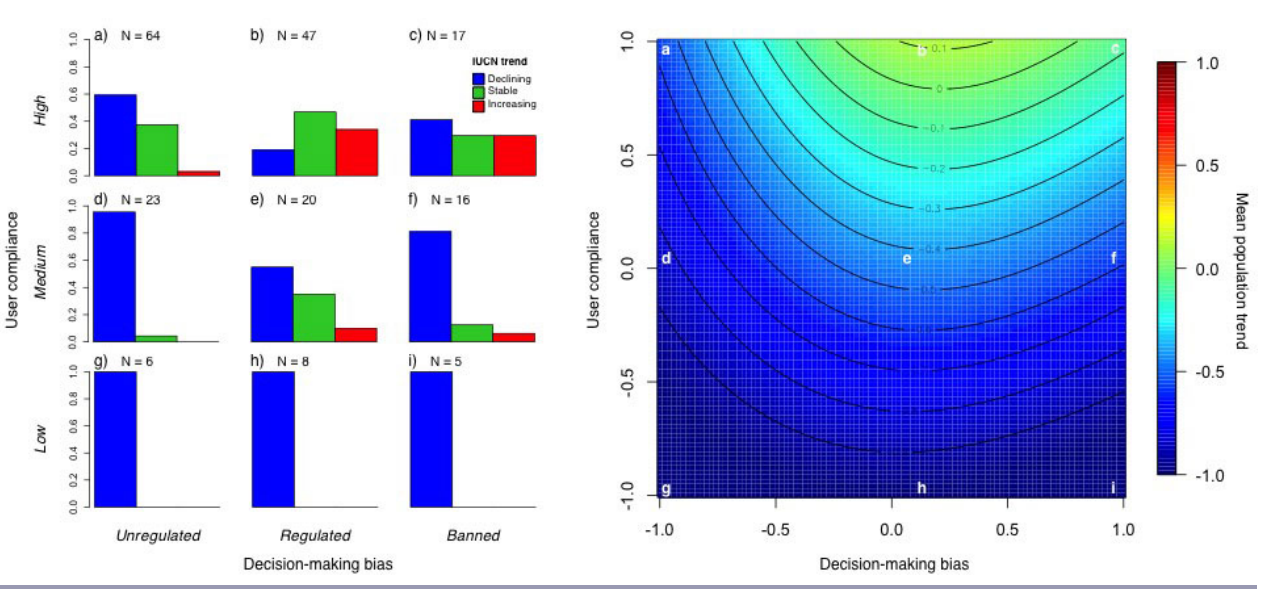
Fig. 4 . Proportion of harvested IUCN Red List species with declining, stable, or increasing population trends for different combinations of decision-making bias and user compliance (panels a-i). N indicates the sample size for each combination. The 2D contour surface represents the interpolated mean population trend across harvested species (-1 = decreasing, 0 = stable, 1 = increasing) for varying levels of decision-making bias and user compliance, and was obtained from a generalized additive model with decision-making bias and user compliance specified as tensor product smooths. The location of letters placed on the prediction surface relate to data shown in panels (a) to